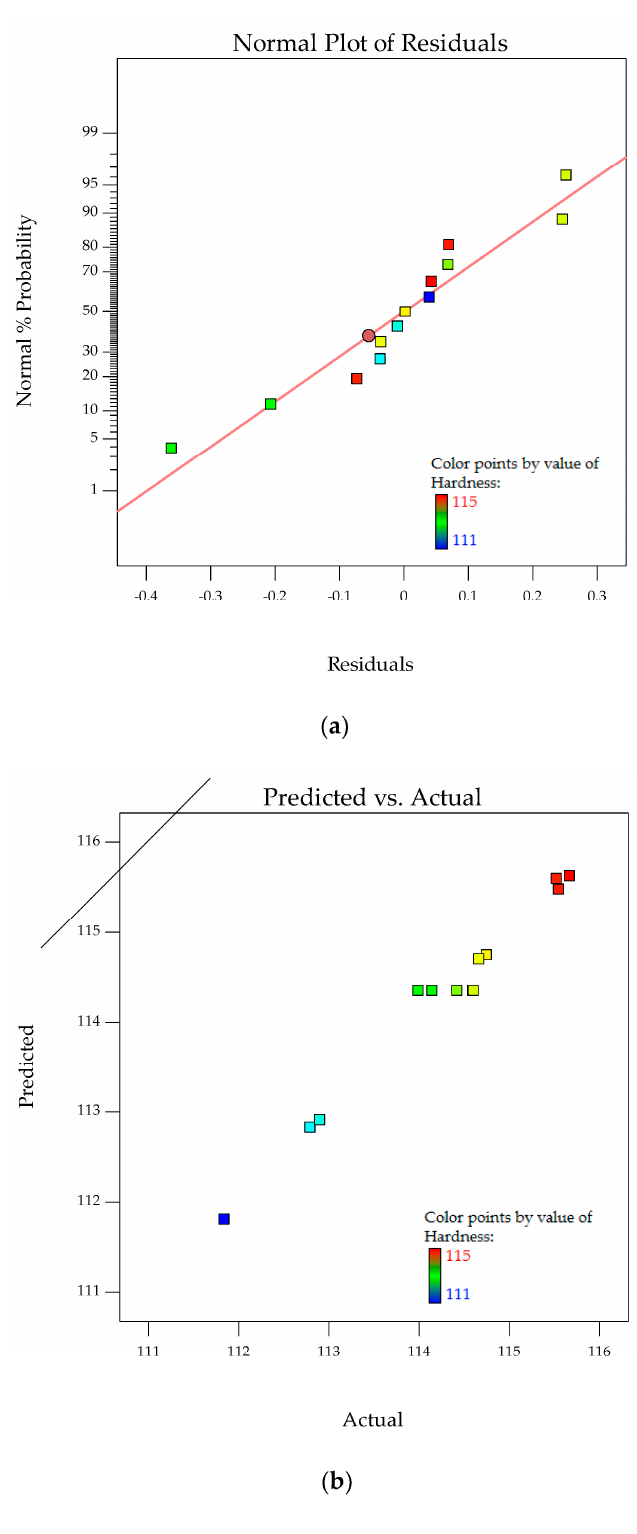
Figure 10. Stochastic error and deterministic portion for hardness of POM composites as ( a ) normal probability plot for residuals; ( b ) predicted versus actual values .